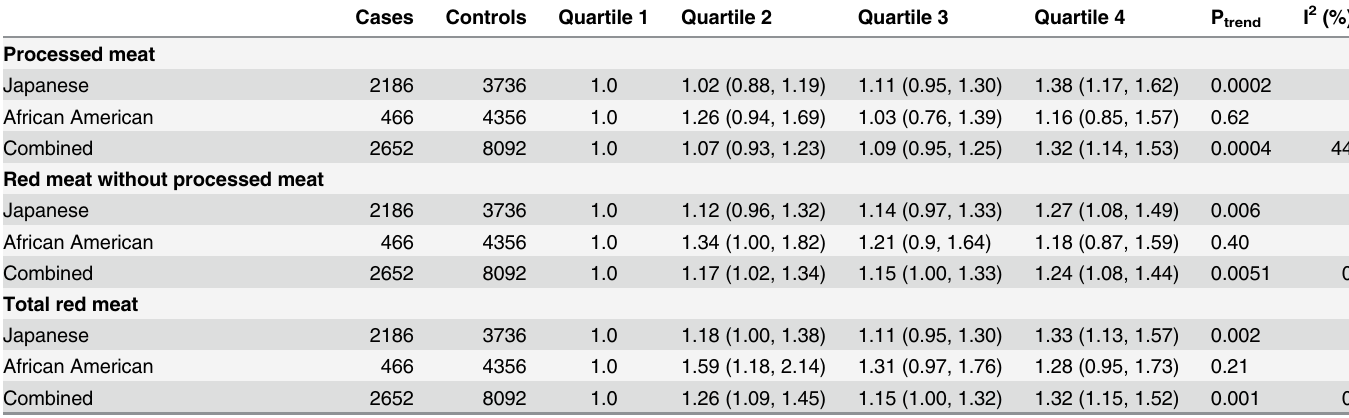
Table 2. Association (odds ratios and 95% confidence interval) between meat intakes and colorectal